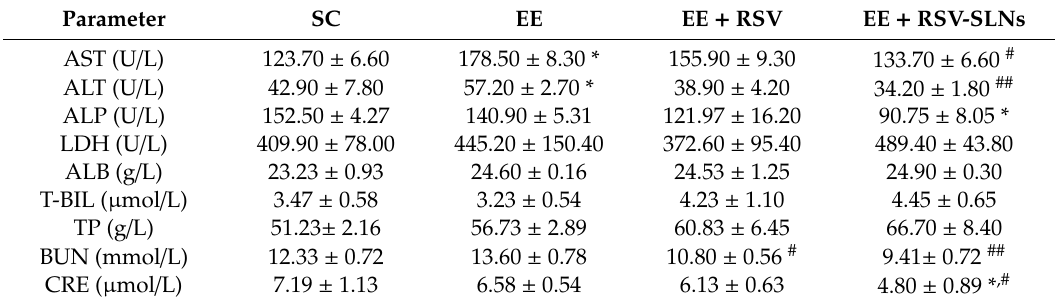
Serum biochemical indicators from four groups of mice: sedentary control (SC), exhaustive exercise group (EE), exhaustive exercise combined with resveratrol supplementation (EE + RSV), exhaustive exercise combined